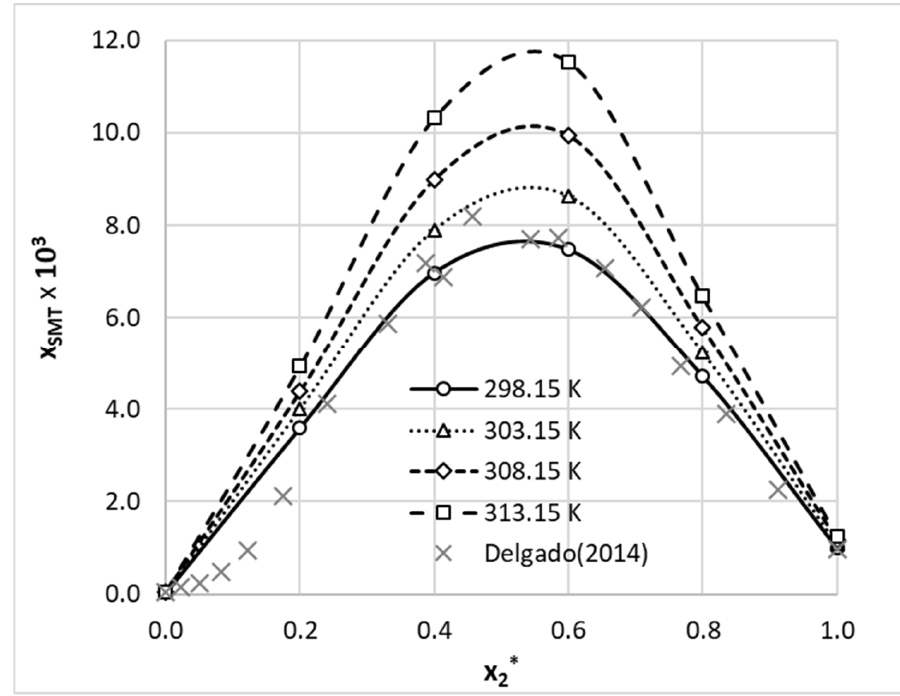
Figure 1. Molar fraction solubility of sulfamethizole in aqueous 1,4-dioxane binary mixtures. On the ordinate, x 2 * represents the mole fraction of organic solvent in solute-free binary solution. The available literature values published by Delgado in 2014 [71] for 298.15 K were marked with gray crosses.